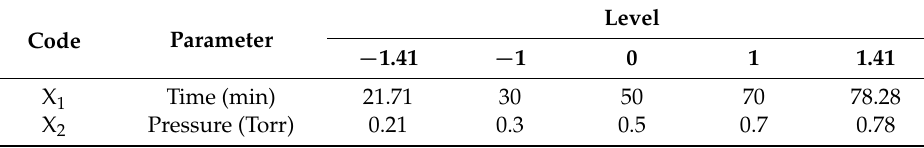
Table 5. Range and level of plasma treatment parameters in CCD